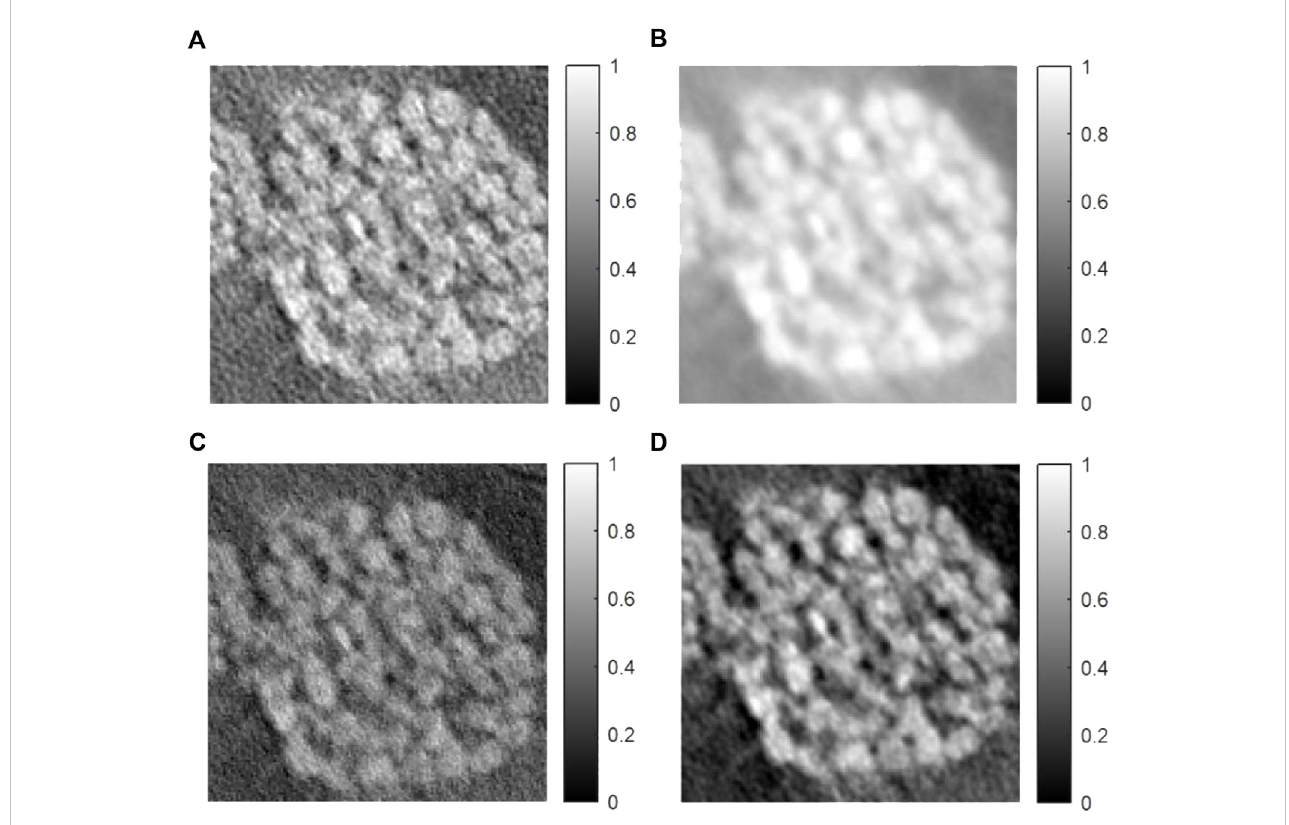
FIGURE 20 Comparison of reconstruction results with zoomed parts: (A) without phase removal, (B) TFDM, (C) LSM and (D)